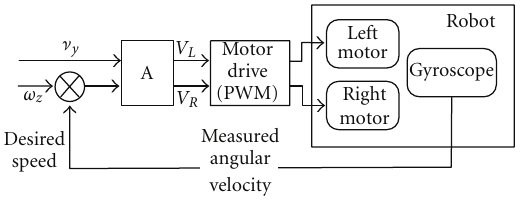
Figure 4: Motion control diagram.